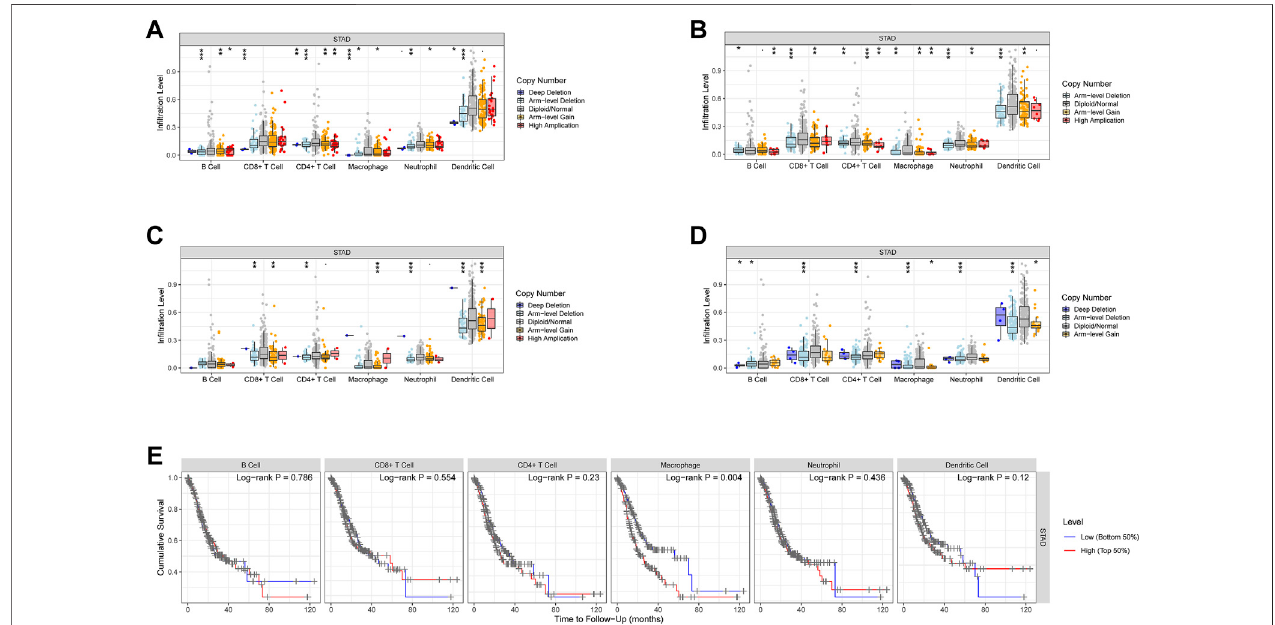
FIGURE9 | CNV ofthe model genesand immunecells inSTAD. (A – D) TheeffectofCNV ofthesemodel geneson the penetration level difference of immune cells. (E) The correlation between the recruitment of immune cells and the survival of STAD patients.